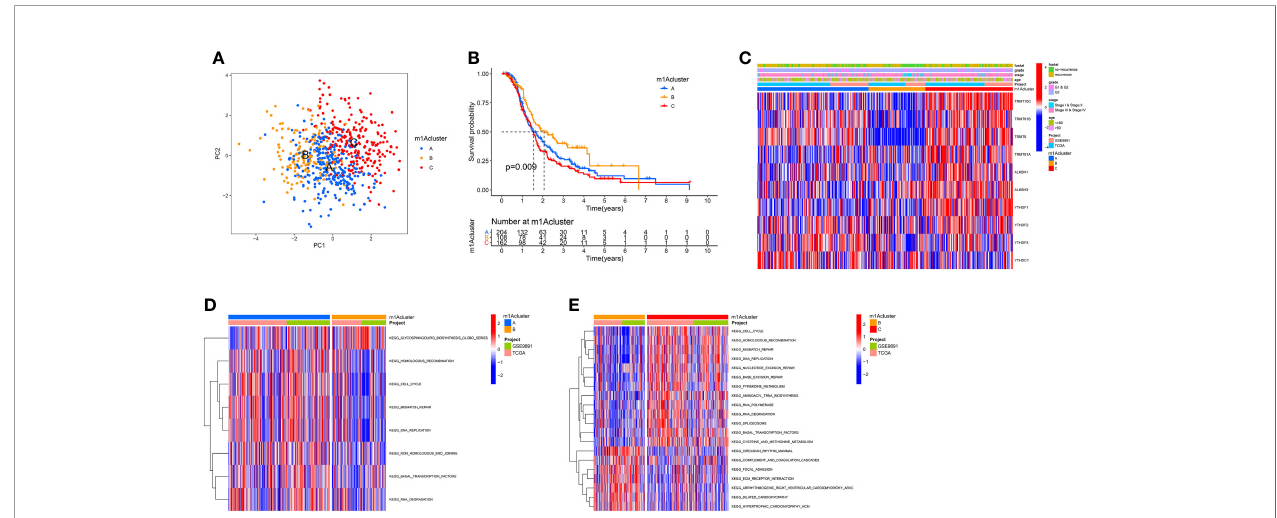
FIGURE 2 | The m1A modi fi cation patterns in OC and biological characteristics of m1A subtypes. (A) The principal component analysis for the transcriptome pro fi les of three m1A modi fi cation patterns. (B) Survival analyses of the three m1A modi fi cation patterns based on 611 OC patients. (C) Unsupervised clustering of 10 m1A regulators in two independent ovarian cancer cohorts. (D, E) GSVA enrichment analysis showing the activation states of biological pathways in distinct m1A modi fi cation patterns. The red represented activated pathways and blue represented inhibited pathways. (D) The m1A cluster A vs m1A cluster B; (E) The m1A cluster B vs m1A cluster